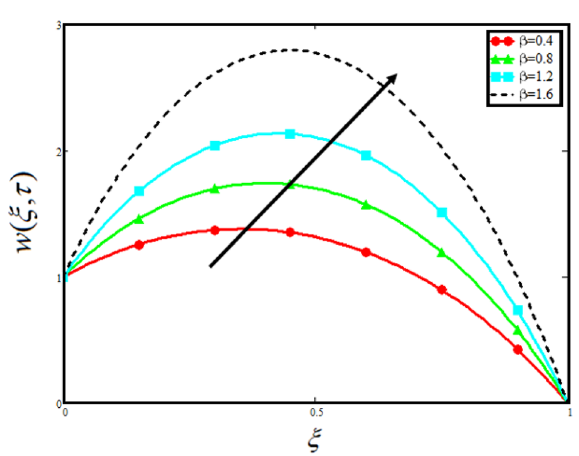
Figure 15. Variation in velocity of nanofluid against different values of β when τ = 1 , φ hnf = 0.02 , Pr = 21 , Gr = 4 , G = 2 , (cid:31) = 3 , α = 0.5 and Re = 1.2